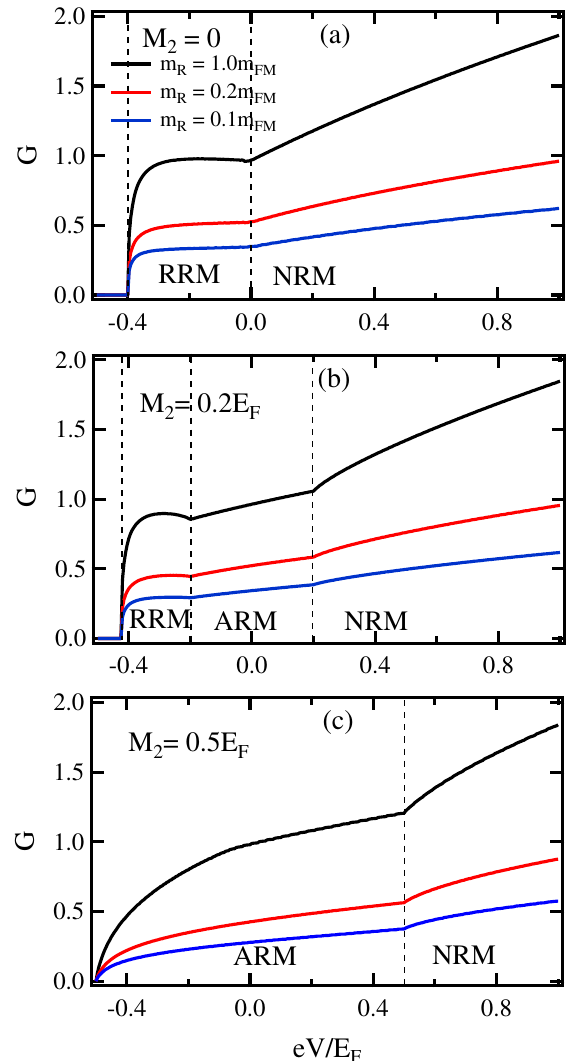
Figure 2. (Color online) Conductance spectra in the applied voltage for different values of the electron effective mass, the barrier potential U 0 = 0. ( a ) the normal RSOC; M 2 = 0, ( b ) M 2 < E α , ( c ) M 2 > E α